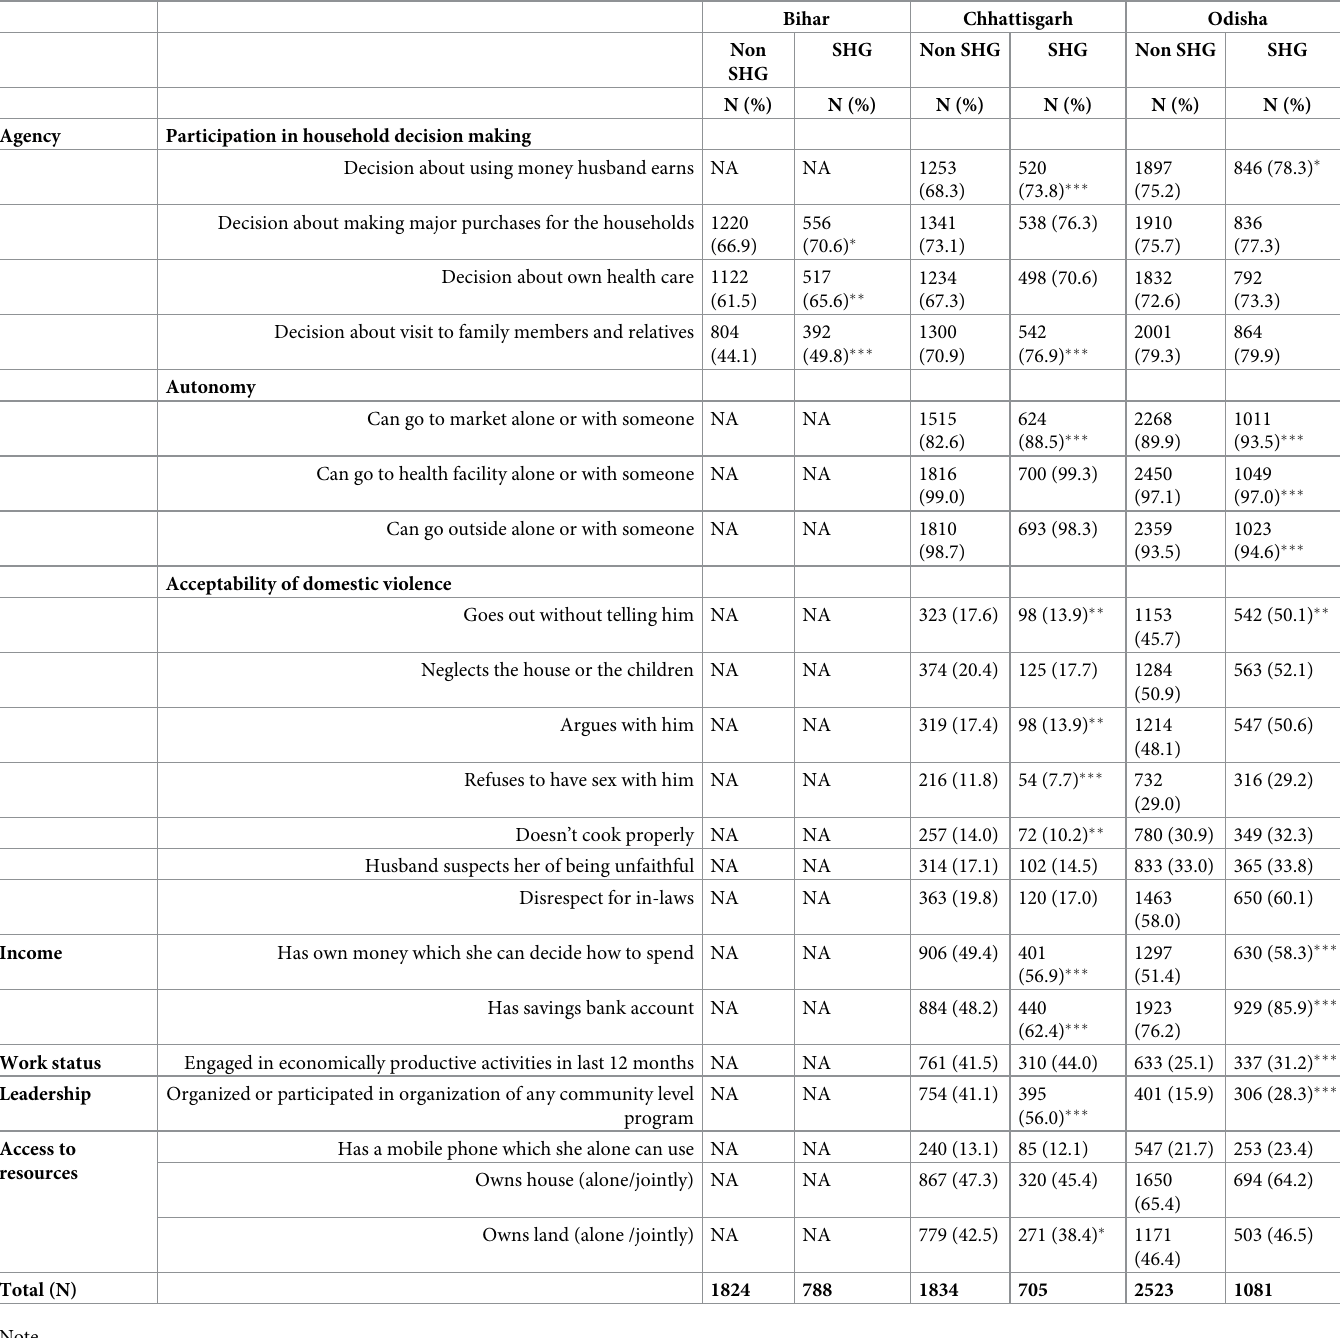
Table 5. Empowerment among SHG and non-SHG member mothers of children under-two in Bihar, Chhattisgarh and Odisha.